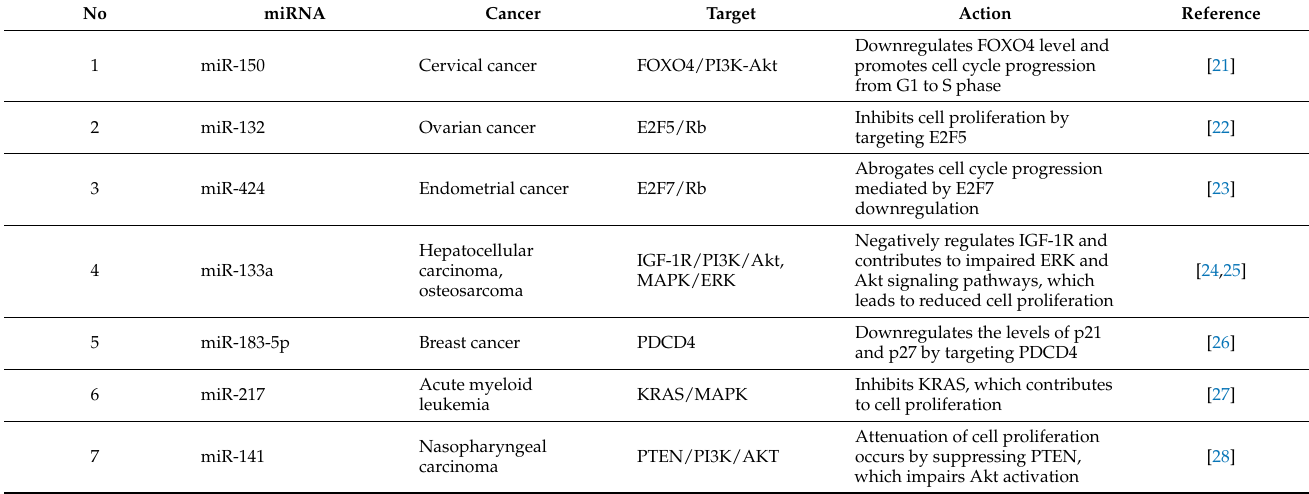
Table 1. The miRNAs implicated in the selective proliferative